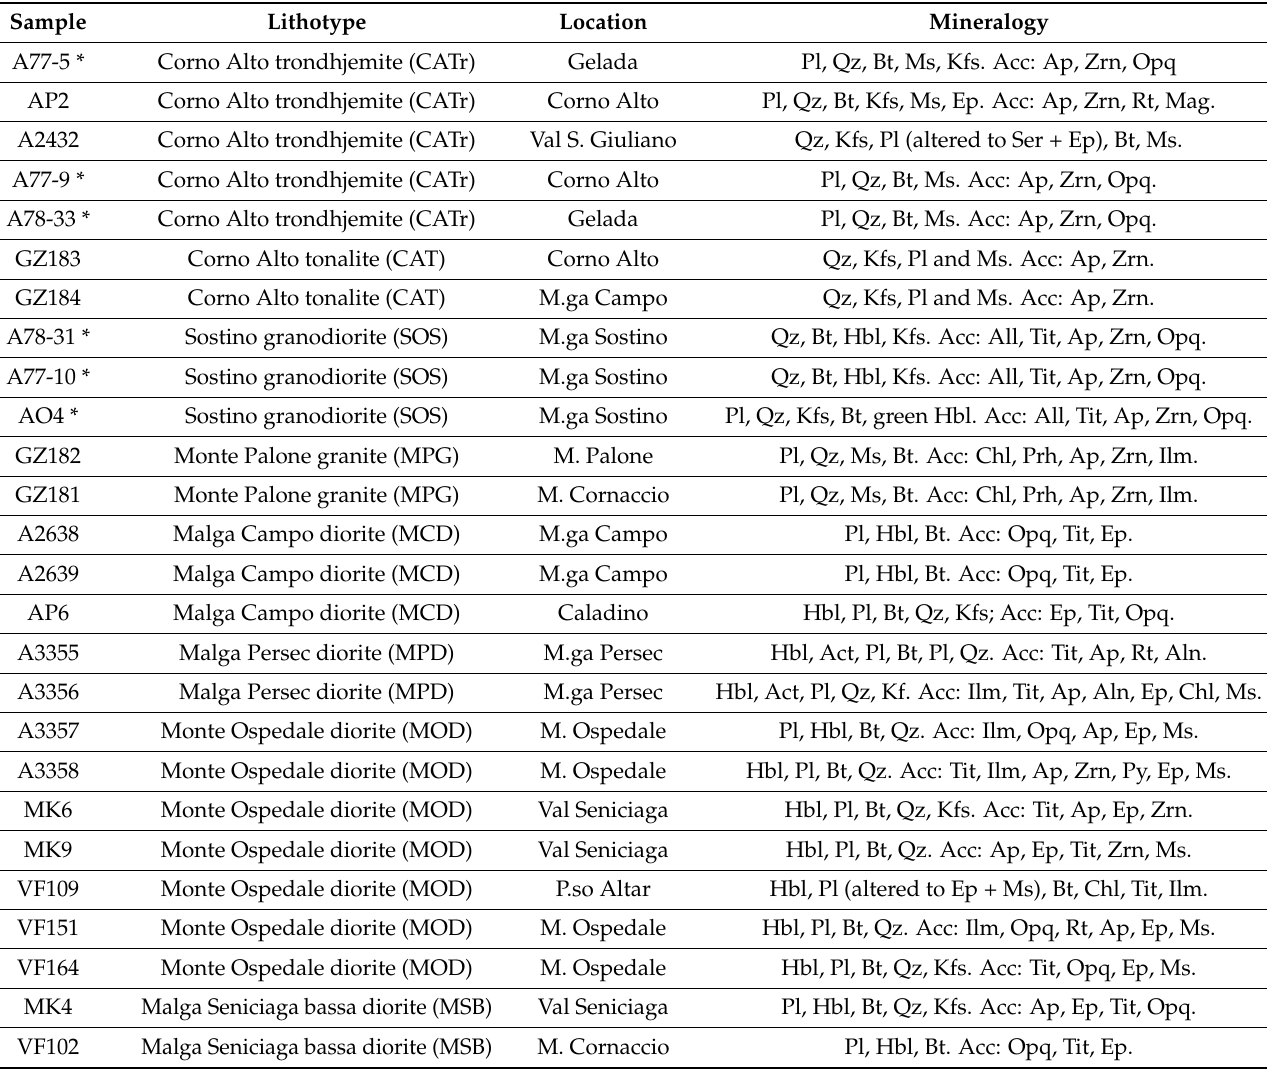
Table 1. Corno Alto–Monte Ospedale samples sites, lithologies and mineral associations. Mineral abbreviations after Whitney and Evans [30]. Samples marked by * after Macera et al. [22]. For accurate locations see Table S1, Figures S2 and